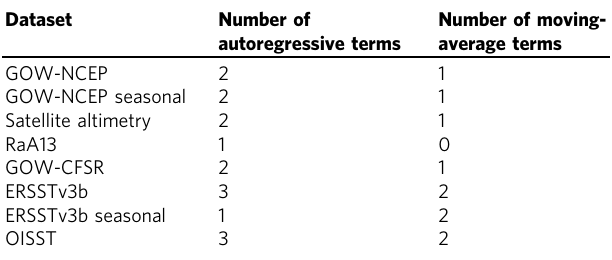
Table 2 Autoregressive models. Autoregressive moving- average models parameters used for each dataset Dataset Number of Number of moving- autoregressive terms average